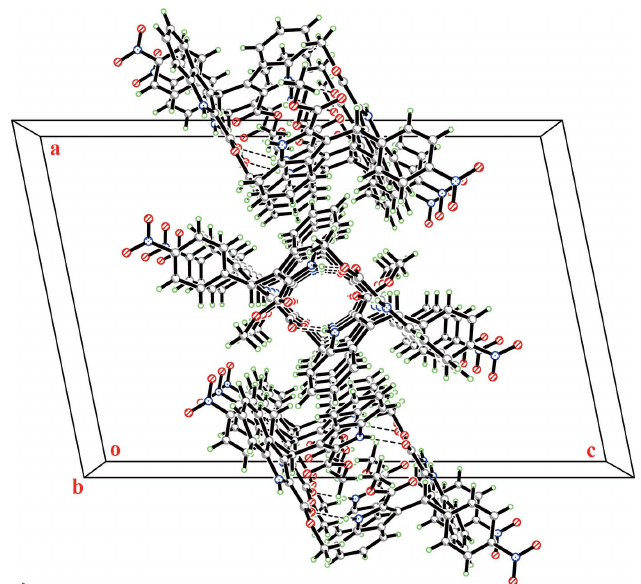
Figure 2 A packing diagram of the title compound. Hydrogen bonds are shown as dashed lines.